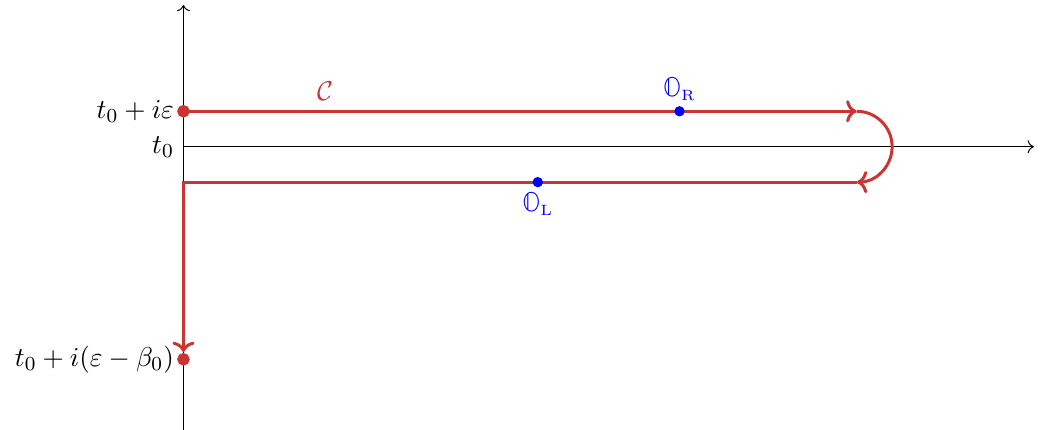
Figure 3 . SK time contour in thermal physics, where the initial state is a thermal state with an entanglement pattern encoded in a Euclidean partition function. The starting and end points of the contour are identi(cid:12)ed. The associated Euclidean (imaginary time) periodicity is set by the inverse temperature (cid:12) 0